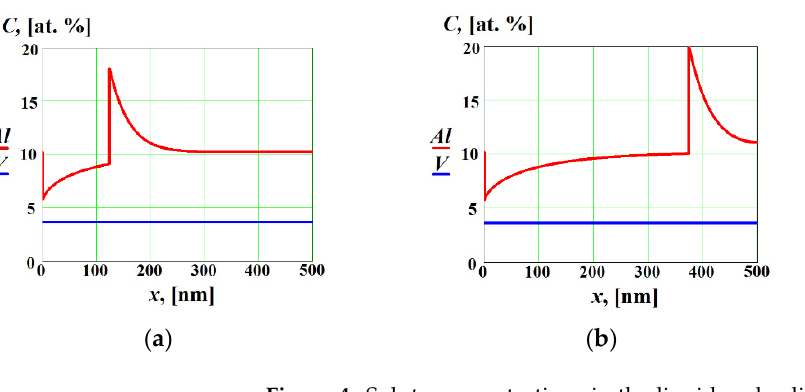
Figure 4. Solute concentrations in the liquid and solid phases as functions of the coordinate x at D VV V < V D and V > V D without cross diffusion effects ( D 12 = D 21 = 0) at different time moments: 1 2 1